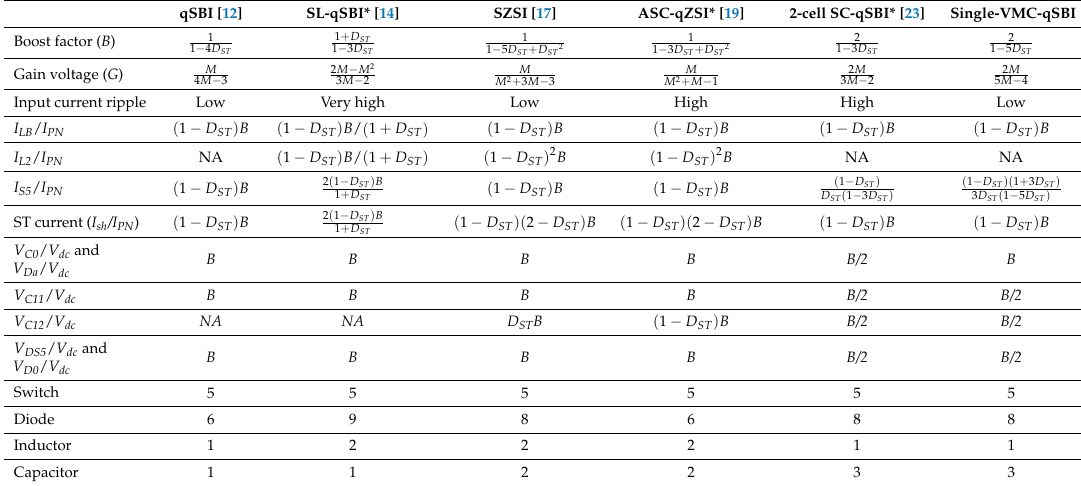
Table 1. Overall comparison of the proposed VMC-qSBI and other active impedance source inverters using the same PWM